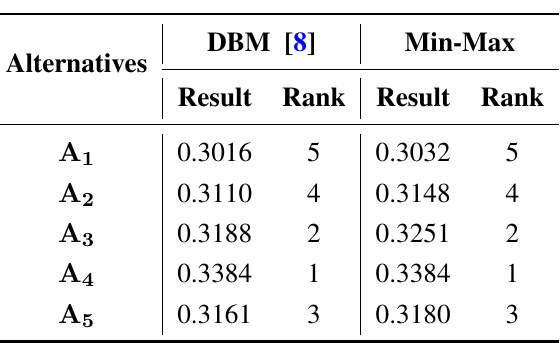
Table 6. Rank of